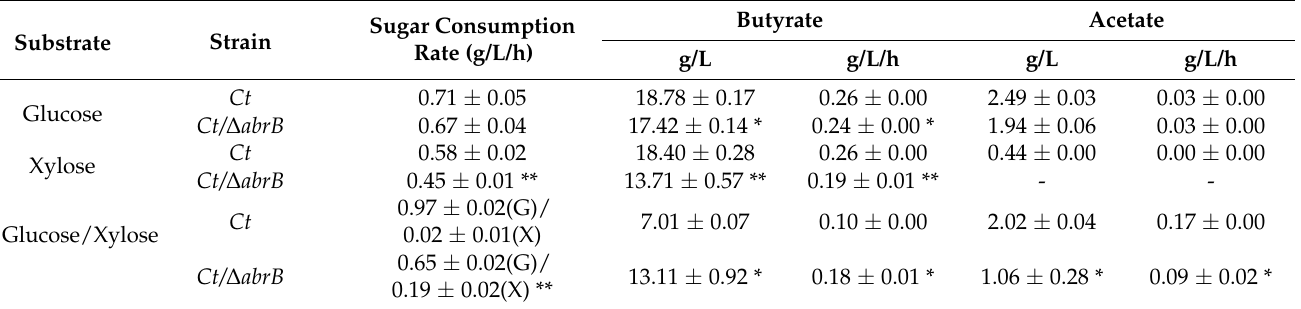
Table 1. Sugar consumption and products formation with different substrates in Ct and Ct/ ∆ abrB